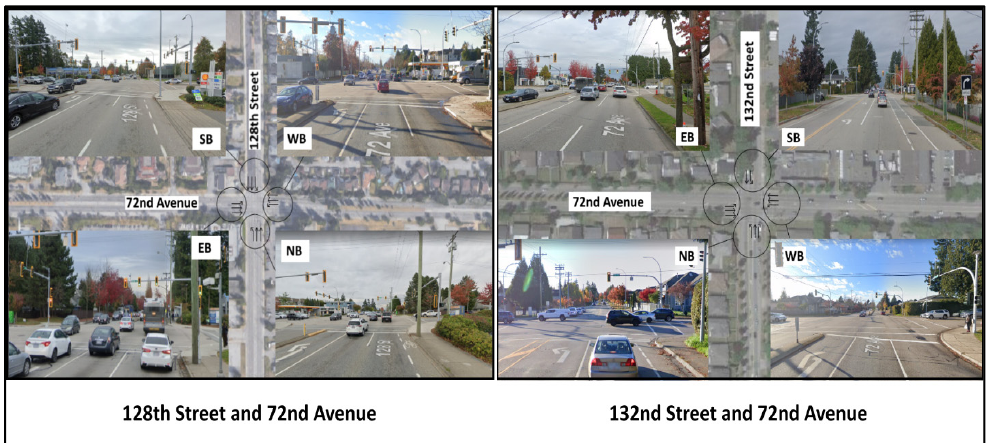
Figure 4. The two intersections: 128th Street and 72nd Avenue, and 132nd Street and 72nd Ave-